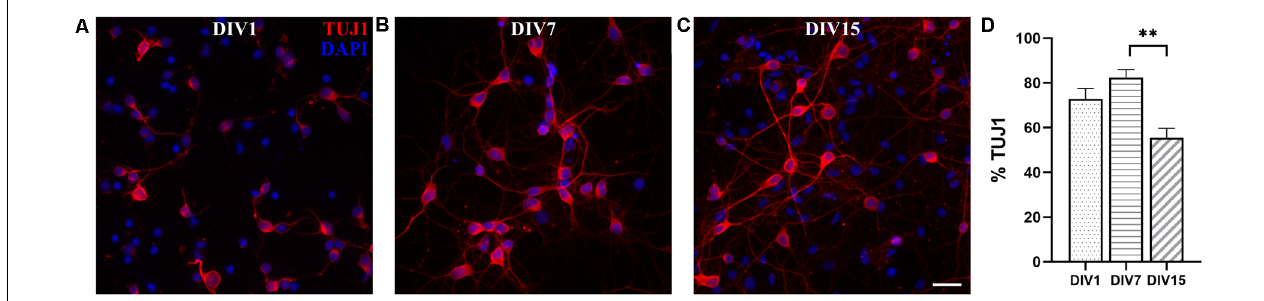
FIGURE 5 | Primary dissociated cortical cultures derived from P16 to P18 opossums. (A) DIV1, (B) DIV7, and (C) DIV15 neuronal cultures stained for β -tubulin III (red). Nuclei were stained with DAPI (blue). (D) Histogram showing percentage of neurons at the time points indicated in panels (A–C) . Kruskal–Wallis test followed by Dunn’s multiple comparisons test. DIV7 vs. DIV15 p = 0.0071 ∗∗ . Scale bar, 25 µ